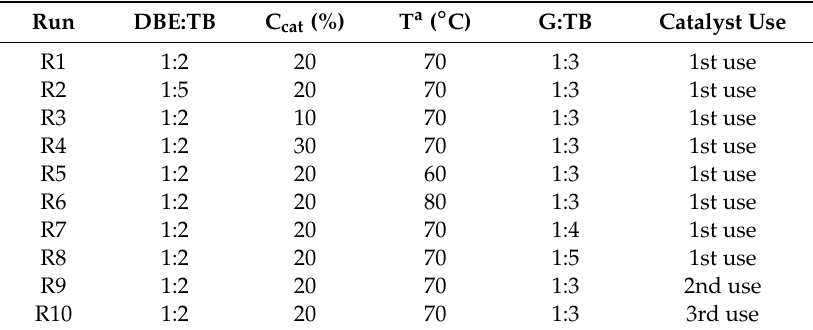
Table 3. Operating conditions of the etherification